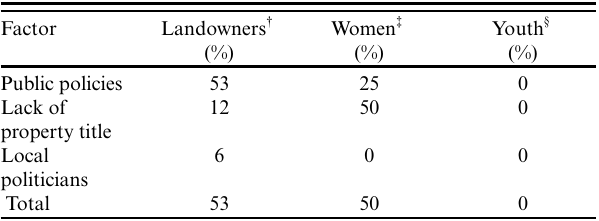
Table 3 . Political factors that influence land-use decisions, as mentioned by